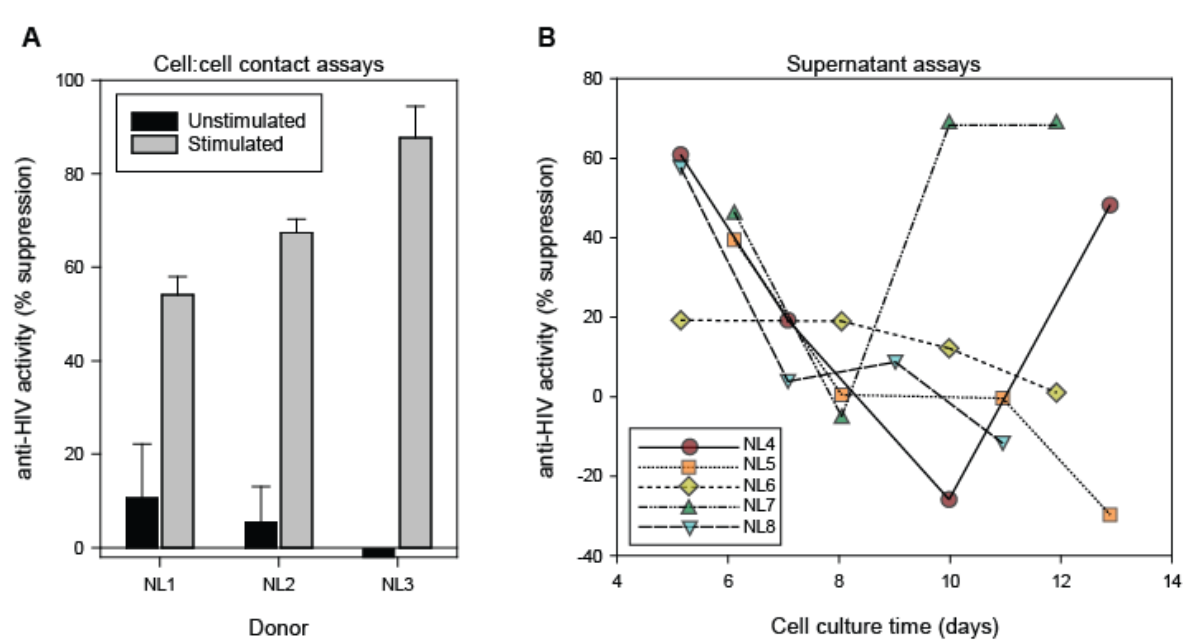
Figure 2. Antiviral activity of CD8+ T cells from healthy blood bank donors . ( A ) Freshly isolated CD8+ T cells (n = 8 donors) were cultured for 3 days in the absence (unstimulated) or presence (stimulated) of anti-CD3/CD28 beads and then added to cultures of acutely HIV-1-infected CD4+ T cells. Shown are results of the CD8+ T cells from 3 representative healthy blood bank donors to suppress HIV-1 replication in CD4+ T cells in cell:cell contact assays. ( B ) Supernatants collected from cultures of stimulated CD8+ T cells were evaluated for anti-HIV-1 activity (n = 31 donors). Results are shown for the anti-HIV-1 activities of CD8+ T cell culture supernatants derived from 5 representative healthy blood bank donors and measured for each cell passage. The temporal CD8+ T cell culture supernatants derived from an individual donor were assayed simultaneously using common acutely HIV-infected CD4+ T cells, whereas the source of the CD4+ T cells varied among assessments of CD8+ T cell culture supernatants from different donors.